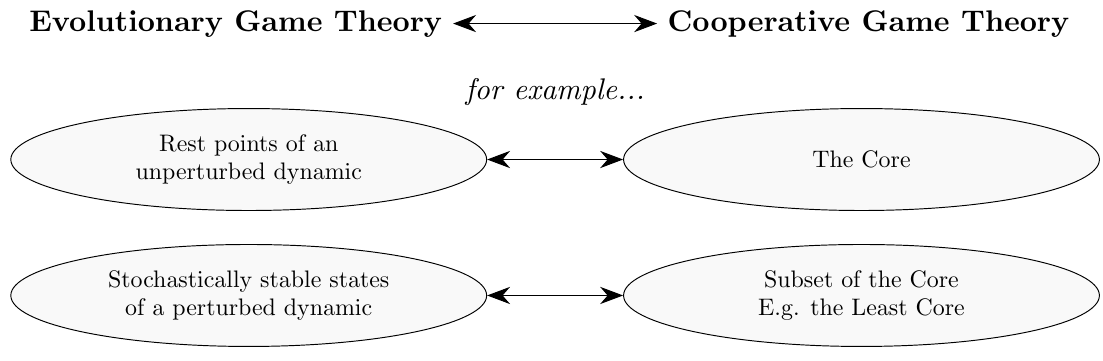
Figure 13. The Evolutionary Nash Program. Connections are made between evolutionary game theory and cooperative game theory. For example, sometimes a state space can be derived from an underlying cooperative game. For some evolutionary dynamics, the rest points will correspond to the core of the associated cooperative game. When these dynamics are perturbed, the stochastically stable states will then correspond to a (possibly strict) subset of the